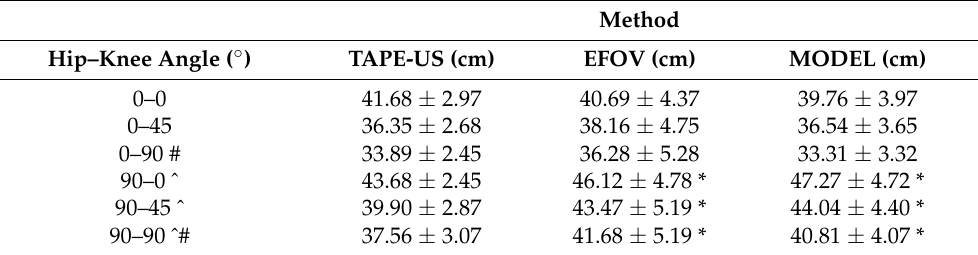
Table 3. Mean ( ± SD) group values of ST length (cm) at six combinations of hip and knee flexion angles, assessed using three different methods (* statistically significant different compared with the TAPE-US and EFOV-US method, ˆ values collapsed across methods and knee joint positions significantly different compared with a 0 ◦ hip flexion angle, # values collapsed across methods, and hip joint angles significantly different compared with a 0 ◦ knee flexion angle, p <